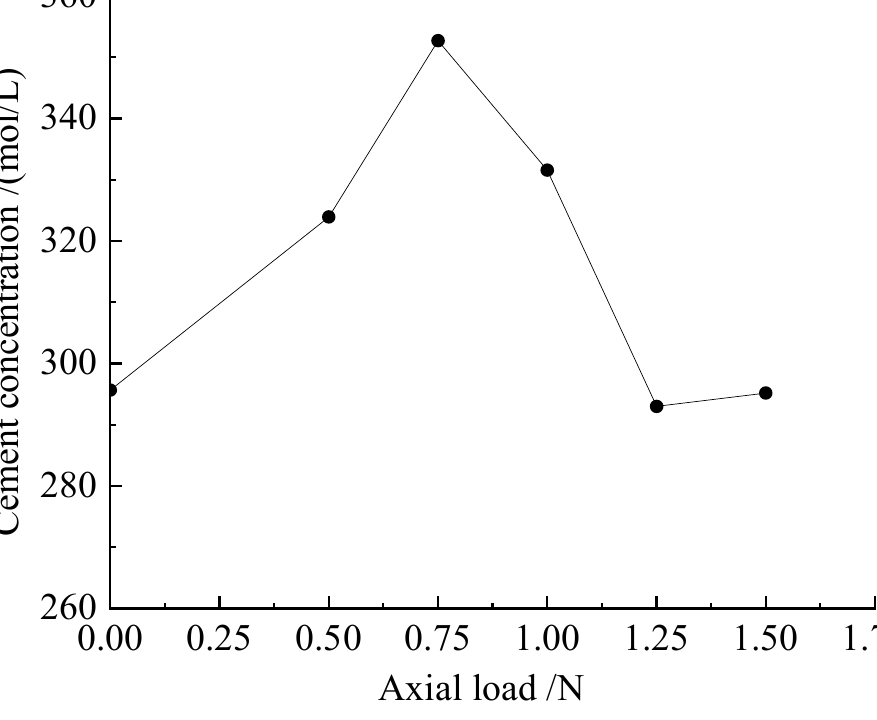
Figure 8. Samples of scheme M: F ‐ plot of cementation solution concentration and axial load.